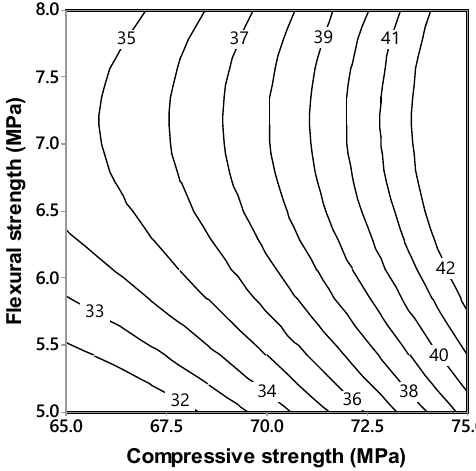
Figure 16. Isoresponse contours for modulus of elasticity vs. compressive strength and flexural strength at 28 days.